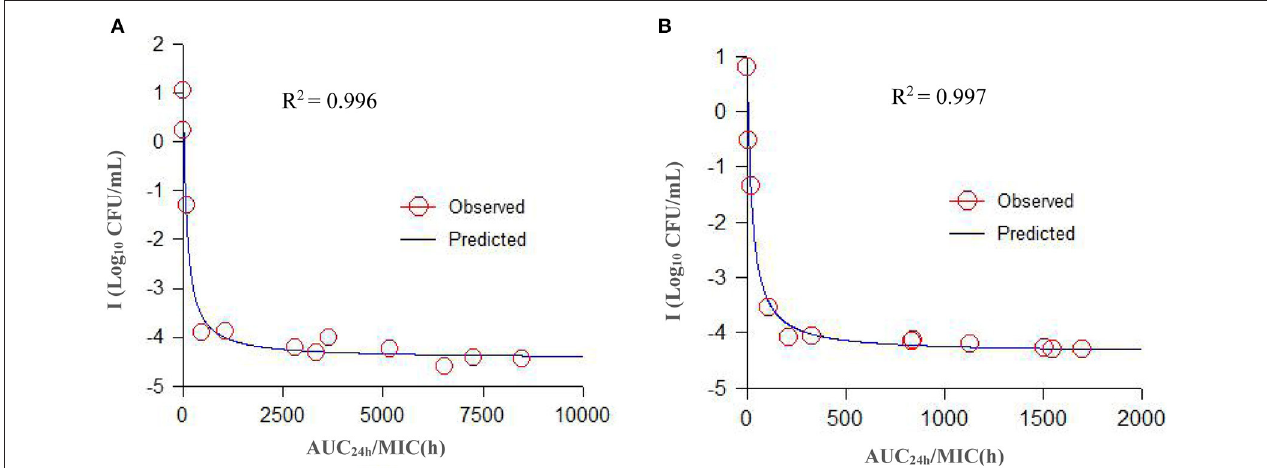
FIGURE 6 | A specimen plot of ex vivo AUC 24h /MIC-antibacterial effect (Log CFU/mL) for A. pleuropneumoniae in serum (A) and TCF (B) . The R 2 value is the coefficient of determination. Values are the mean ± standard deviation ( n = 6). SD bars have been omitted for